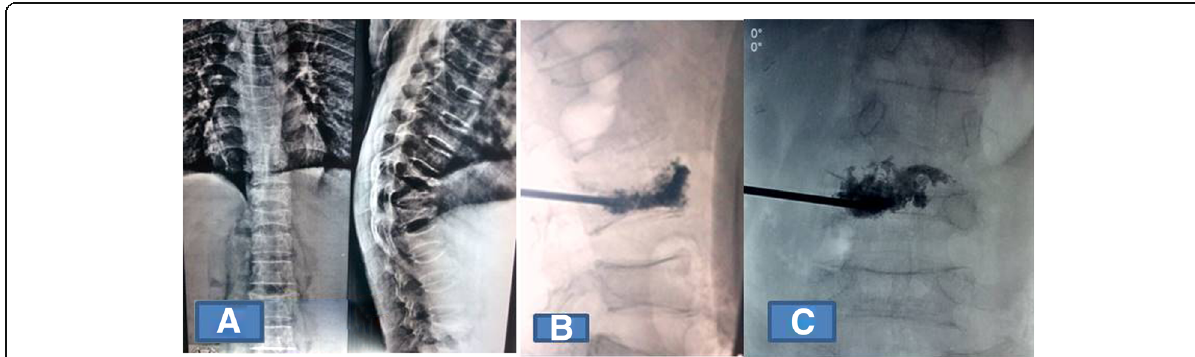
Fig. 5 A 29-year-old male who is suffering from thalassemia with history of regular interval repeated blood transfusions had lower lumbar back pain and inability to walk since last 6 months with tenderness at L4 vertebral level. a X-ray AP and lateral view of thoracolumbar spine showing multiple vertebral osteoporotic collapse with few vertebrae showing biconcave end plates. b DSA lateral view image showing unipedicular injection of cement in to collapse L4 vertebrae. c DSA AP view showing adequate filling of L4 vertebrae by cement mixture more on one half. The patient was a known case of thalassemia with history of multiple blood transfusions. Though there were multiple vertebral collapse, but patient had symptoms of pain and tenderness only at lumbar region. So, vertebroplasty was planned for L4 vertebrae. On follow-up, the patient had significant relief in pain and is now able to walk without support